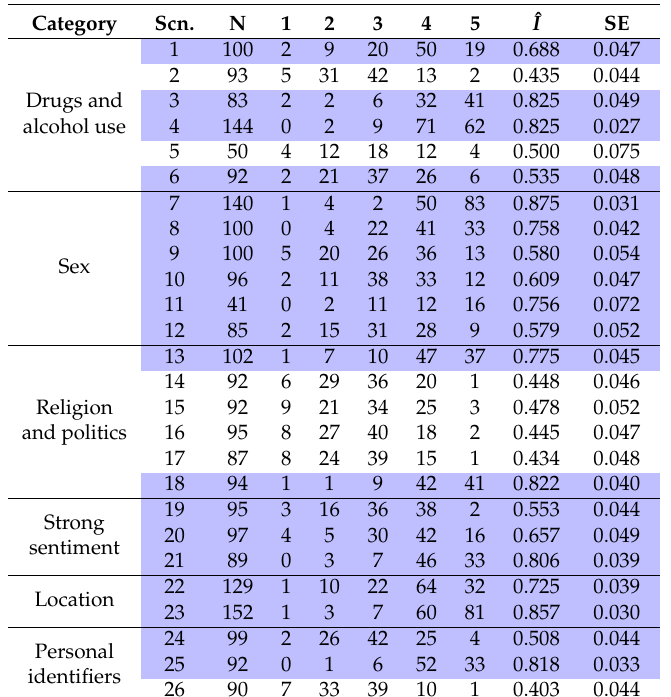
Table 5. Criticality index and severity frequencies of each